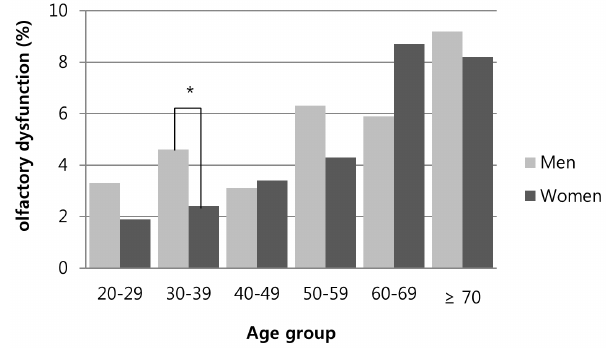
Figure 1. Prevalence of subjective olfactory dysfunction by age groups and genders. There were increasing tendency of olfactory dysfunction prevalence with increasing age in both genders, asterisk; p ,